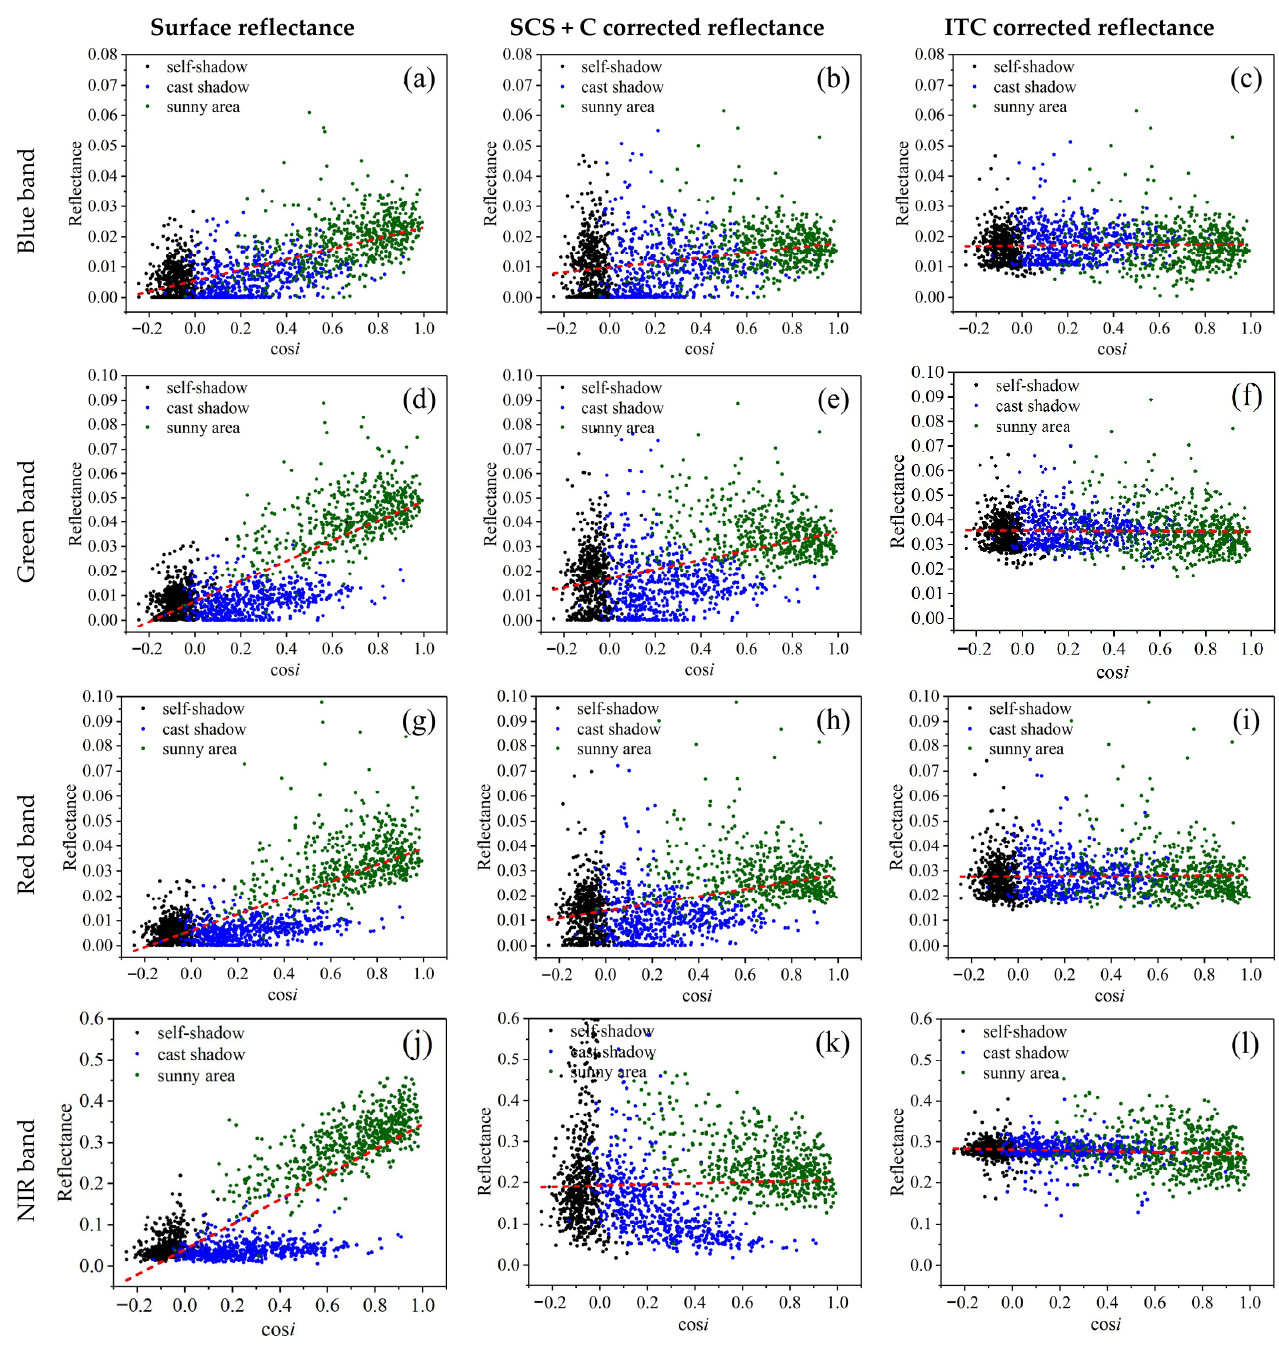
Figure 8. Scatter plots of waveband reflectance vs. cos i : ( a ) surface reflectance of blue band vs. cos i , ( b ) SCS+C corrected reflectance of blue band vs. cos i , ( c ) ITC corrected reflectance of blue band vs. cos i , ( d ) surface reflectance of green band vs. cos i , ( e ) SCS+C corrected reflectance of green band vs. cos i , ( f ) ITC corrected reflectance of green band vs. cos i , ( g ) surface reflectance of red band vs. cos i , ( h ) SCS+C corrected reflectance of red band vs. cos i , ( i ) ITC corrected reflectance of red band vs. cos i , ( j ) surface reflectance of NIR band vs. cos i , ( k ) SCS+C corrected reflectance of NIR band vs. cos i , ( l ) ITC corrected reflectance of NIR band vs. cos i . The red dashed line is linear regression of band reflectance vs. cos i .